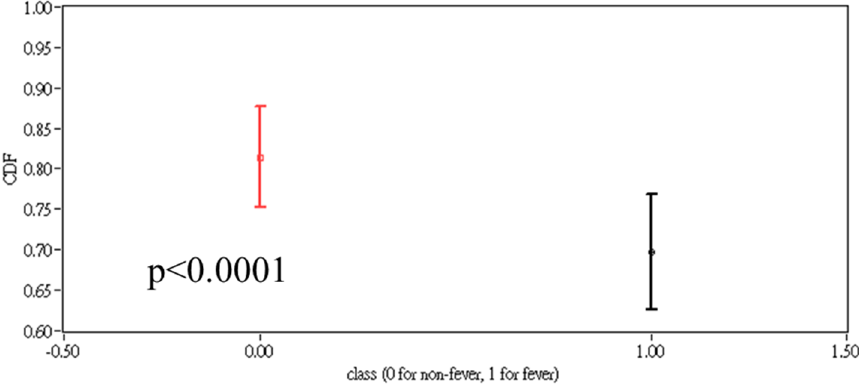
Figure 3. Distribution of CDF(E( k = 19)) of iPR of 2 groups (0 for the non-Fever group; 1 for Fever group) and the value of p .